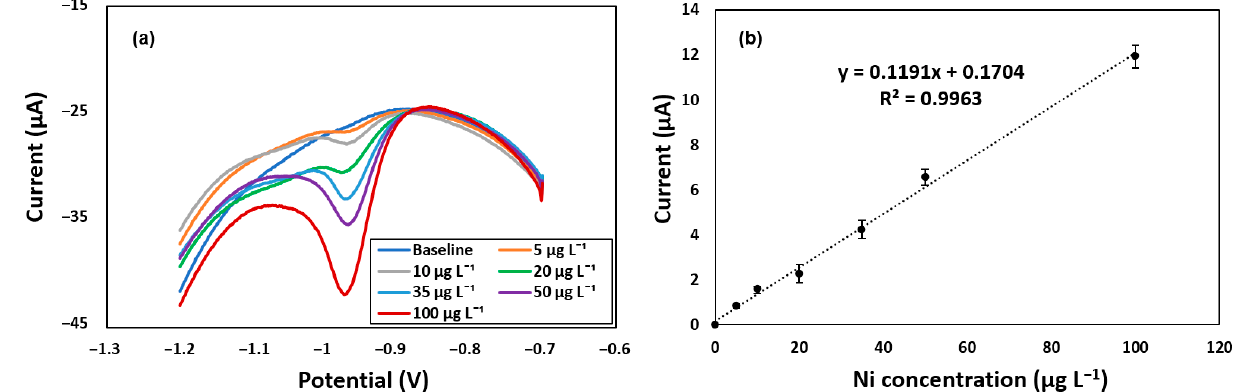
Figure 3. Characterization and evaluation of the Bi-chitosan sensor for Ni(II) detection. ( a ) SWAdCSV with various Ni(II) concentrations (5–100 µ g L − 1 ) and ( b ) a corresponding calibration curve. Deposition time is 120 s with a deposition potential of − 0.9 V, frequency of 120 Hz, amplitude of 50 mV, and DMG concentration of 0.2 mM.